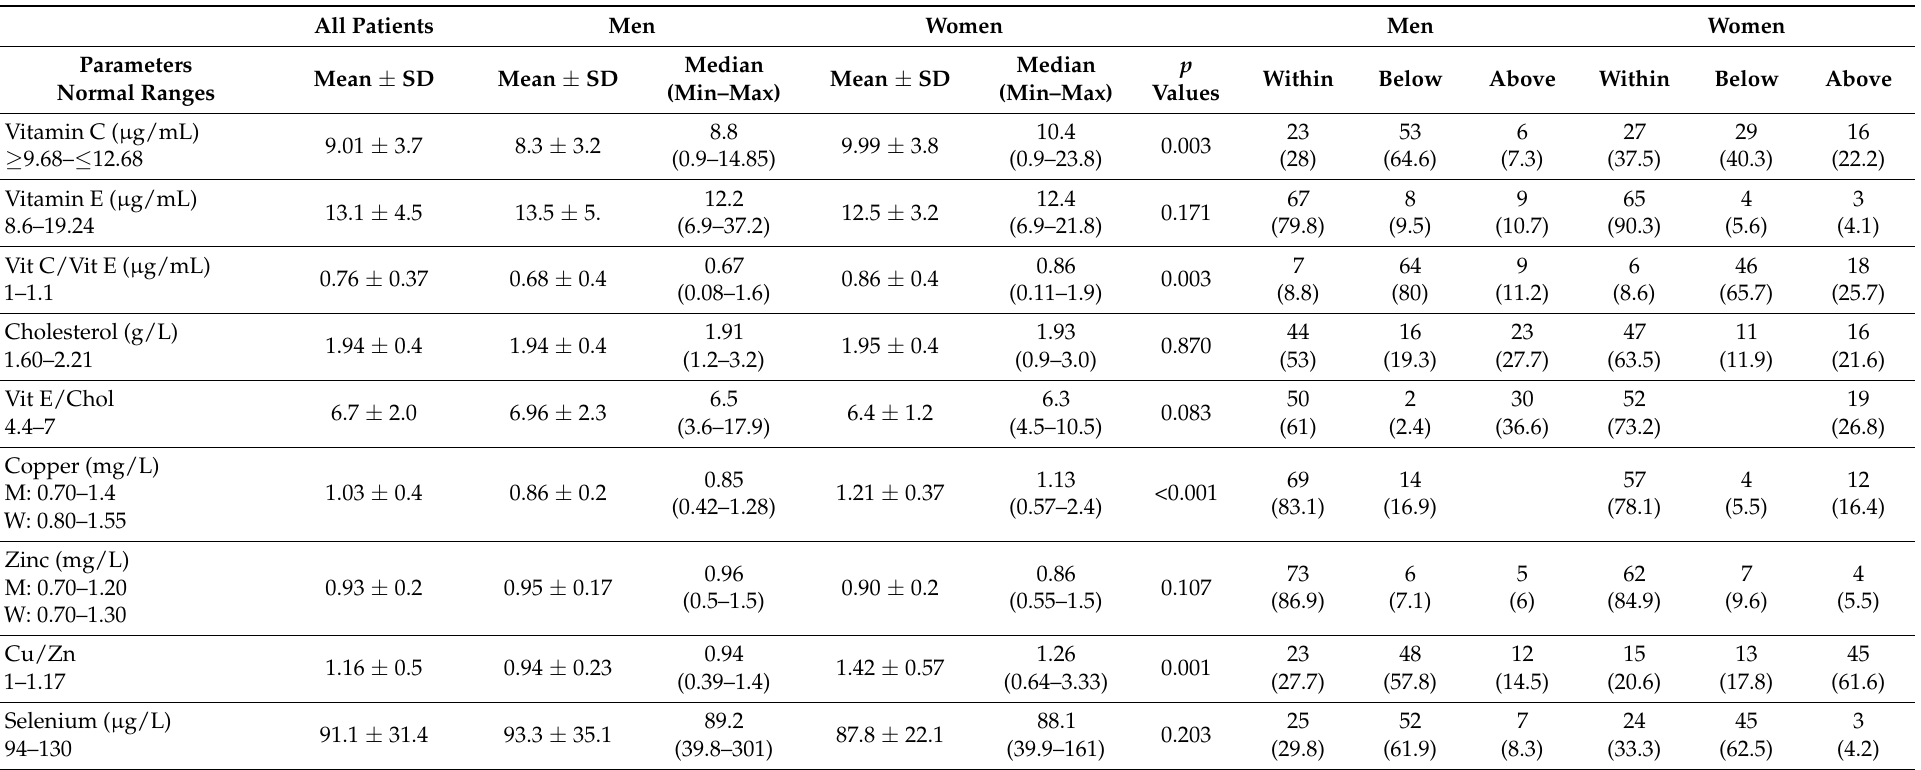
Table 9. Plasma concentrations of vitamins and minerals and their adequacy in 159 patients with